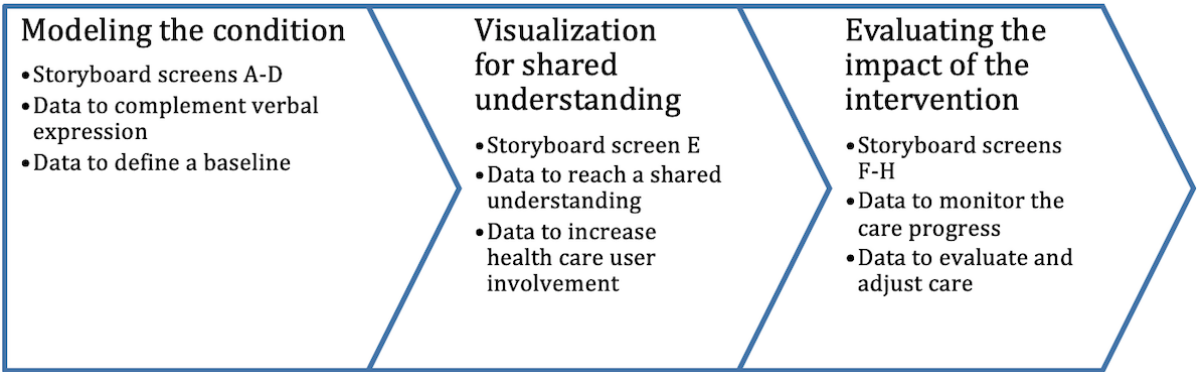
Figure 2. Three types of support posture scanning can provide for data-driven personalization of